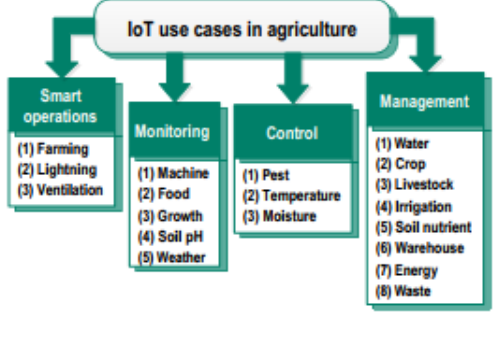
Figure 10. Use cases for the application of IoT in